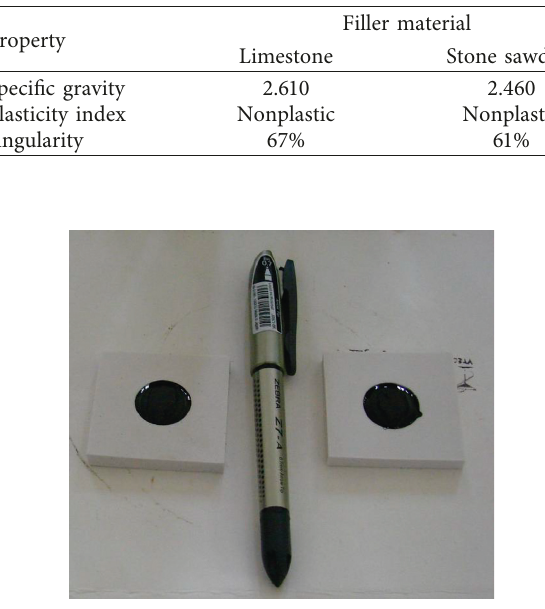
Figure 1: Samples for DSR testing.